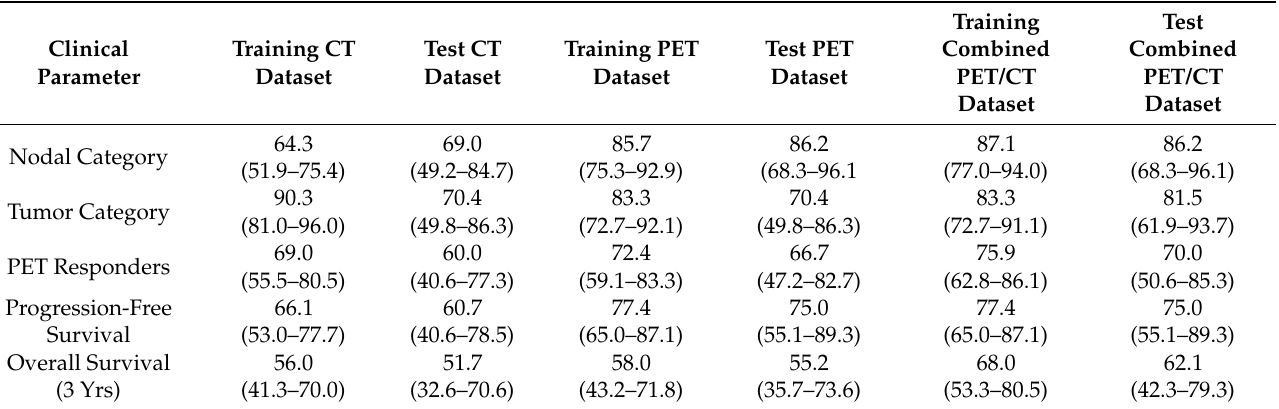
Table 4. Diagnostic accuracy of training and test datasets for various clinical parameters; 95% confidence intervals are presented within